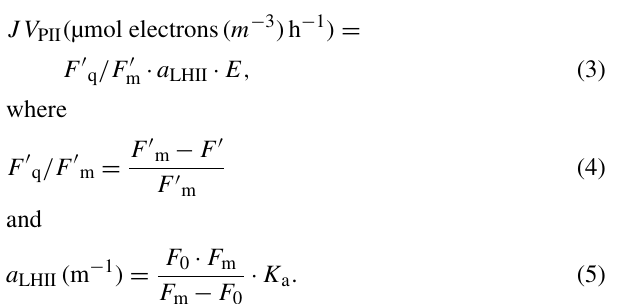
Table 1. The derived photosynthetic parameters used in the text (see Oxborough et al., 2012, and Silsbe et al., 2015, for more information). Variables used in Eqs. (1)–(8) are not included but discussed in the text. Description unit Parameters derived from fluorescence induction curve F 0 Minimum fluorescence, measured at zeroth flashlet of an FRRf single turnover measurement when all PSII reaction centers (RCII) are open; estimate for chlorophyll a concentration F m Maximum fluorescence, reached at n th flashlet of an FRRf single turnover mea- surement when all PSII reaction centers are closed Rate of reopening of a closed RCII σ PSII Effective absorption cross section of PSII photochemistry Parameters calculated from parameters derived from fluorescence induction curve JV PII PSII charge separation rate per unit volume (see Eq. 3) Quantum efficiency of PSII under dark conditions (see Eq. 4) Dimensionless a LHII Absorption coefficient of PSII light harvesting (see Eq. 5) RCII Functional PSII reaction centers per volume (see Eq. 6) Parameters derived from fluorescence light curve (FLC) α PSII